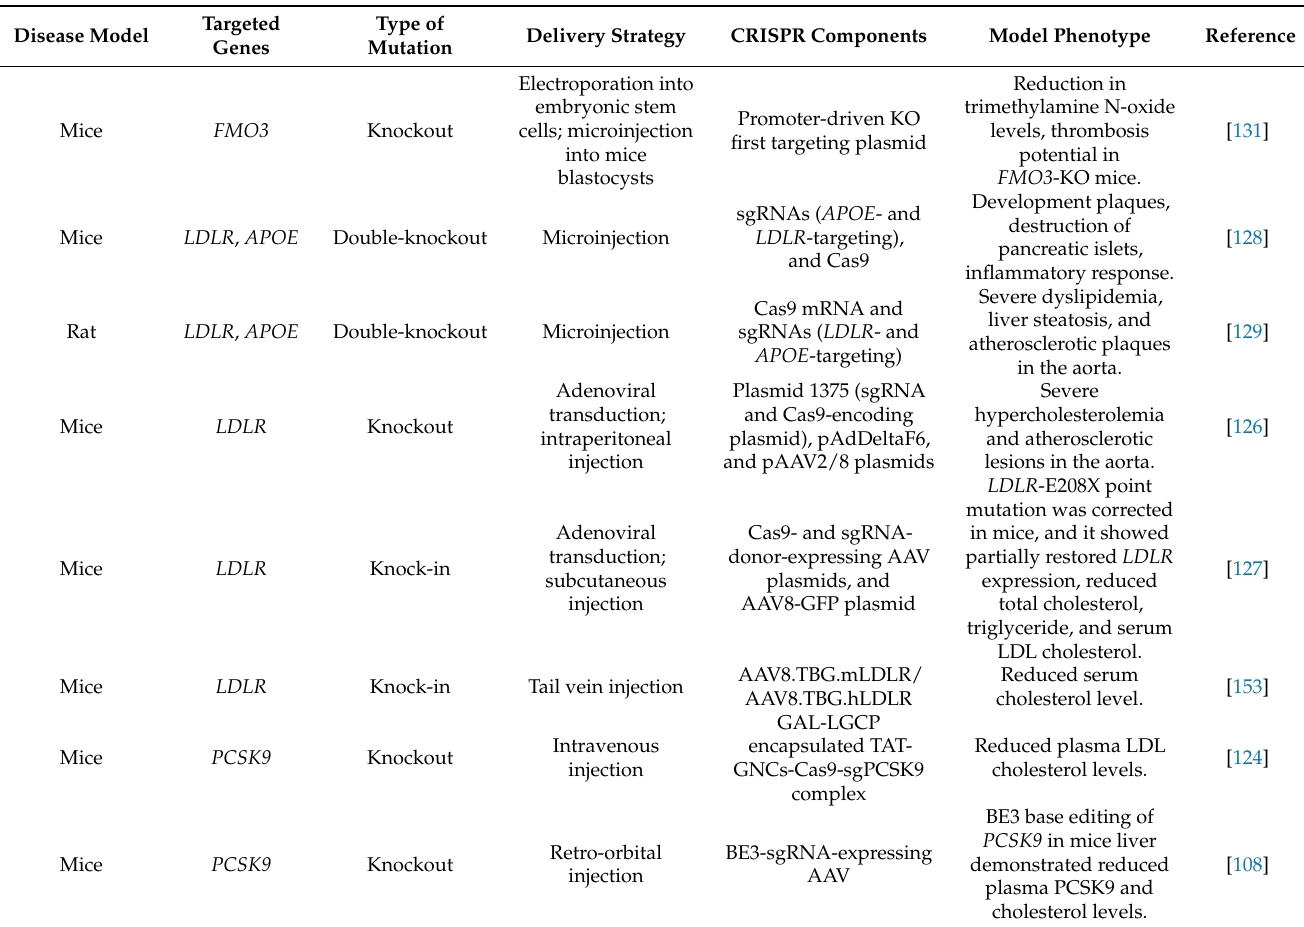
Table 2. CRISPR/Cas9 genome editing in atherosclerosis models (in vivo). Disease